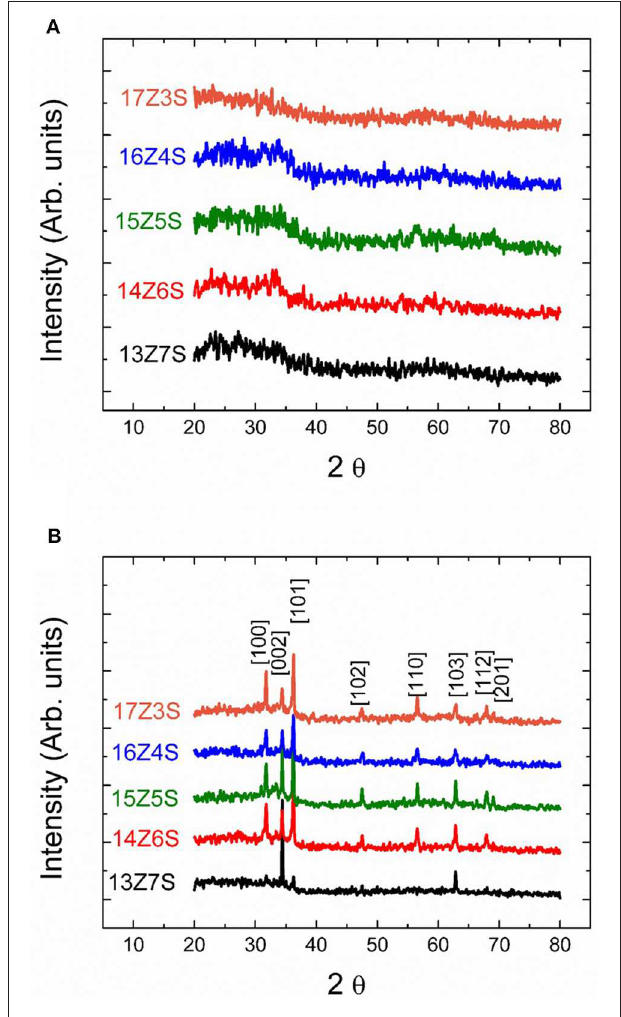
FIGURE 2 | The XRD patterns of ZnO/SnO 2 nanostructures (A) before thermal annealing (as-sprayed) and (B) after thermal annealing at 350 ◦